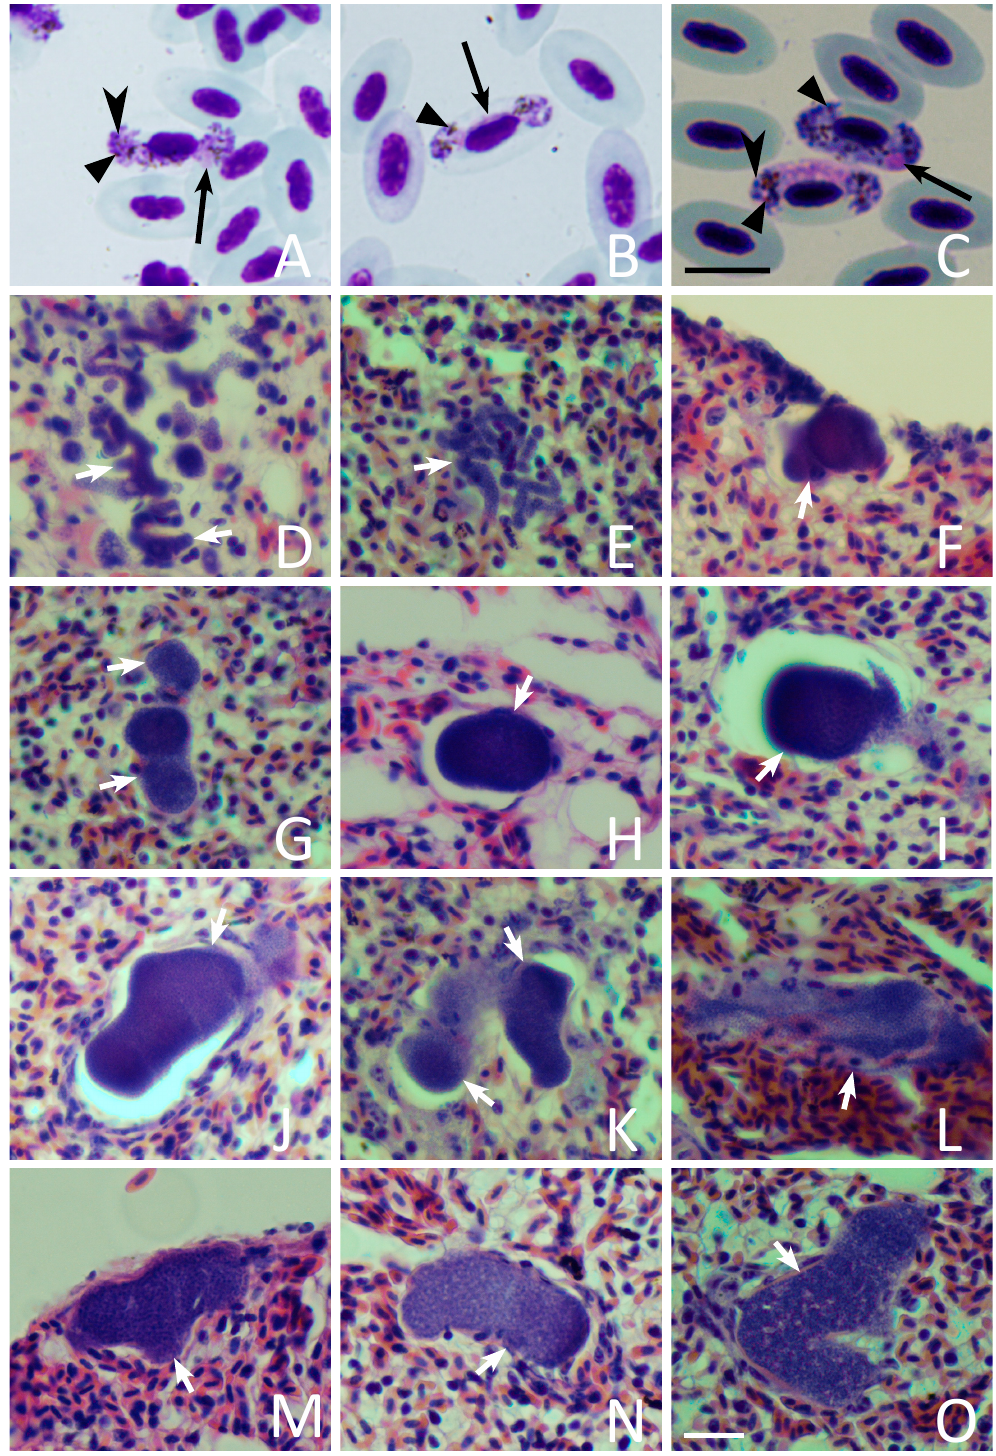
Figure 2. Gametocytes ( A – C ) and lung meronts ( D – O ) of Haemoproteus attenuatus (cytochrome b lineage hROBIN1) in Figure 2. The same section of the lungs of European robin Erithacus rubecula, with meronts of Haemoproteus attenuatus naturally infected European robin Erithacus rubecula : ( A, B ) growing macrogametocyte ( A ) and microgametocyte ( B ); ( C ) (cytochrome b lineage hROBIN1) shown at different magnifications, × 100 ( A ), × 200 ( B ), × 400 ( C ), and × 1000 ( D ). A simple fully grown macrogametocyte (top) and microgametocyte (bottom); ( D,E ) groups of numerous early developing meronts; ( F – O ) variously shaped maturing meronts, including those at the stage of differentiation of merozoites ( J – O ). Note that white arrow shows the same meront in this group of parasites. Location of meronts in groups is a characteristic feature of growing gametocytes of this parasite are markedly attenuated ( A,B ), which is particularly visible in microgametocyte ( B ). this infection ( A , B ). Note that meronts are markedly different in size and shapes, but the majority did not exceed 50 µ m at Prominent roundish volutin granules are well-visible in gametocytes ( A,C ), particularly microgametocytes, in which they the biggest diameter. Scale bar is 50 µ m for all